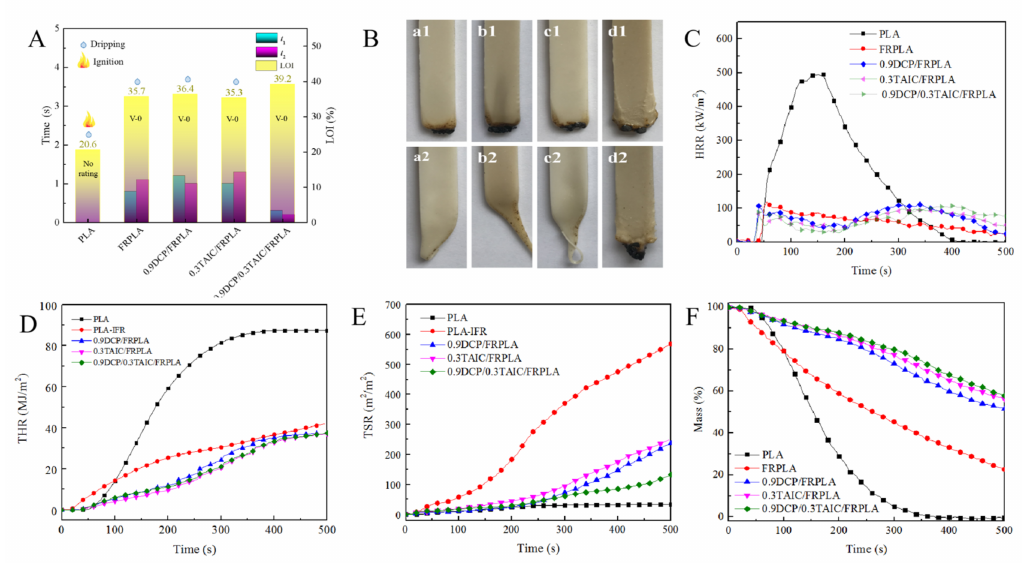
Figure 5. The flame retardant properties of PLA and PLA composites: ( A ) LOI and UL 94 ver- tical burning test; ( B ) digital image of composite UL94 sample (a: FRPLA, b: 0.9DCP/FRPLA, c: 0.3TAIC/FRPLA, d: 0.9DCP/0.3TAIC/FRPLA); ( C ) HRR curves; ( D ) THR curves; ( E ) TSR curves; ( F ) mass loss